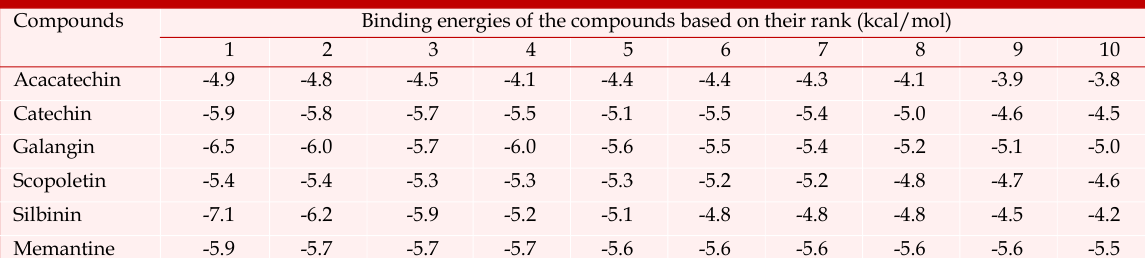
Intermolecular energies of the compounds based on their rank